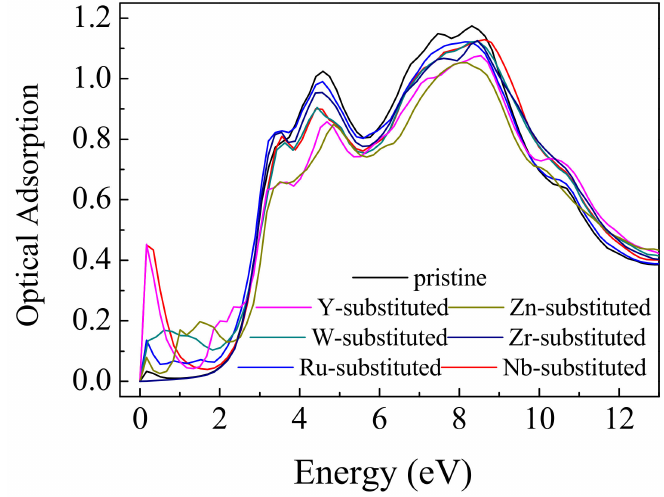
Figure 6. Comparison of the optical absorption of the transition metal-substituted CH 3 NH 3 PbI 3 / TiO 2